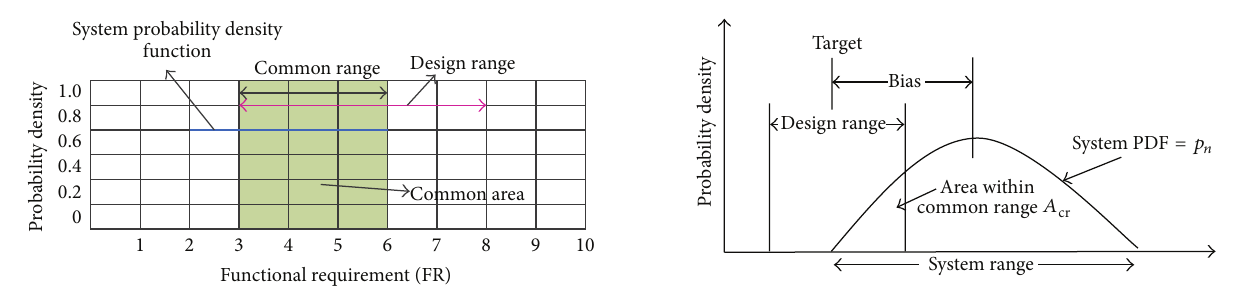
Figure 2: Design range, system range, common range, and PDF of a FR [1].